Question: Sum up the contents of this chart in one sentence.
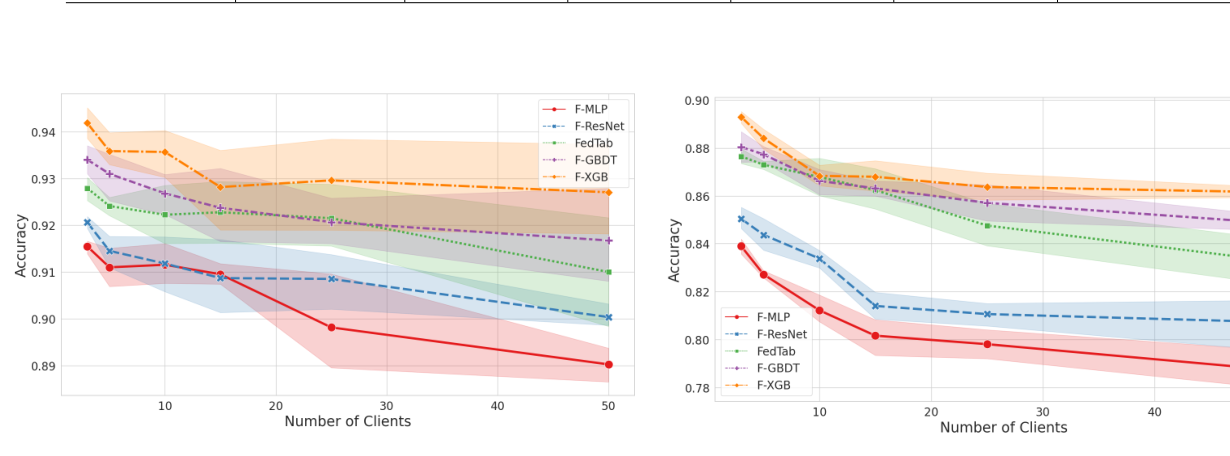
Answer: Models’ test accuracy for 3, 5, 10, 15, 25 and 50 clients on FEMNIST dataset in homogeneous setting.